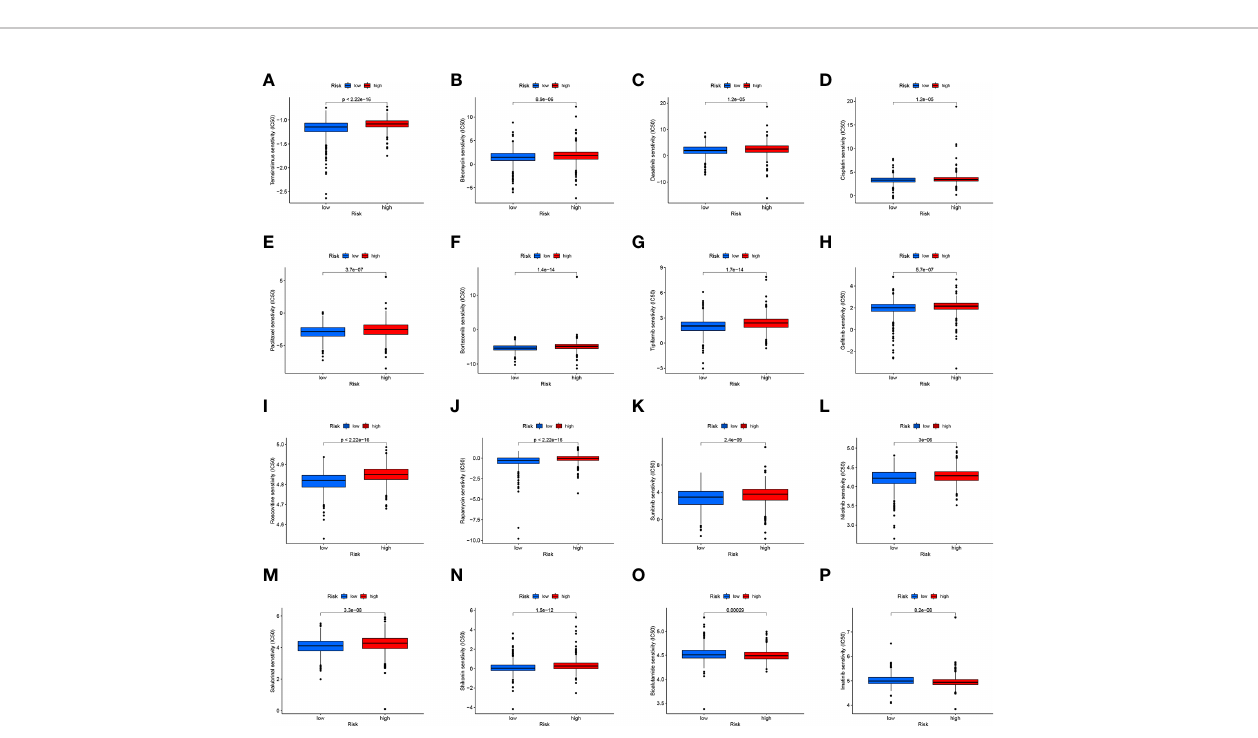
FIGURE 10 | (A – P) Analysis of drug sensitivity in high- and low-RS groups. The distribution of IC50 score. The abscissa represents the high- and low-RS groups, and the ordinate represents the distribution of the IC50